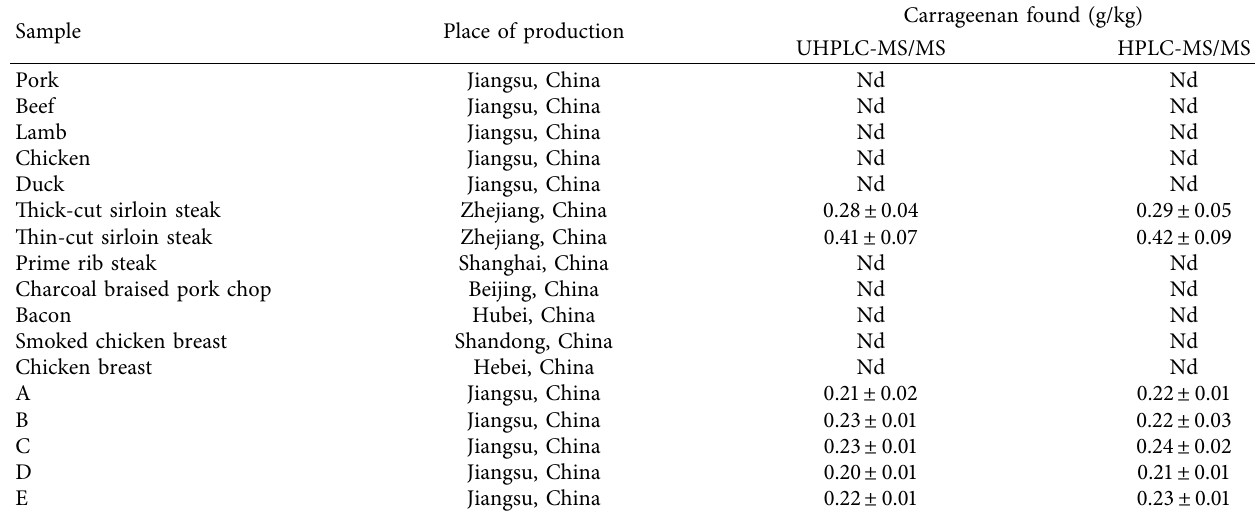
Carrageenan found (g/kg) UHPLC-MS/MS HPLC-MS/MS